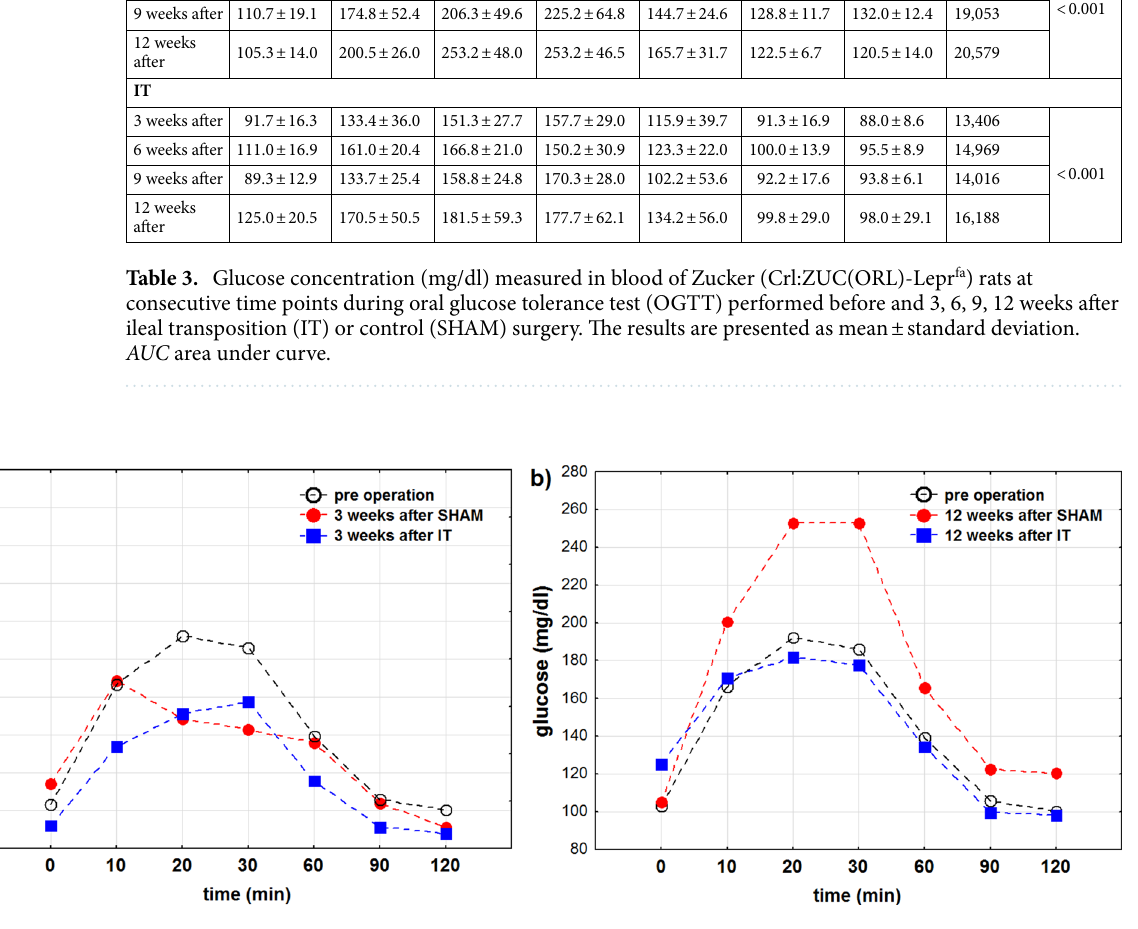
Figure 2. Time profile (min) of mean values of glucose concentration (mg/dl) in 3 weeks ( A ) and 12 weeks ( B ) after operation. For comparison the concentration before operation were marked in black. For reader’s convenience, the points are connected with dashed